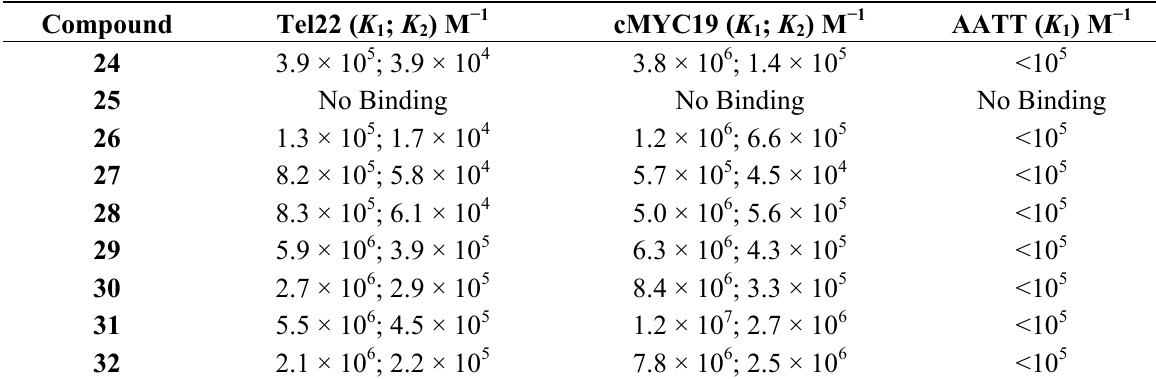
Table 2. Equilibrium binding constants of the trimethine cyanine analogs with Tel22 and cMYC19 quadruplex sequences obtained from SPR